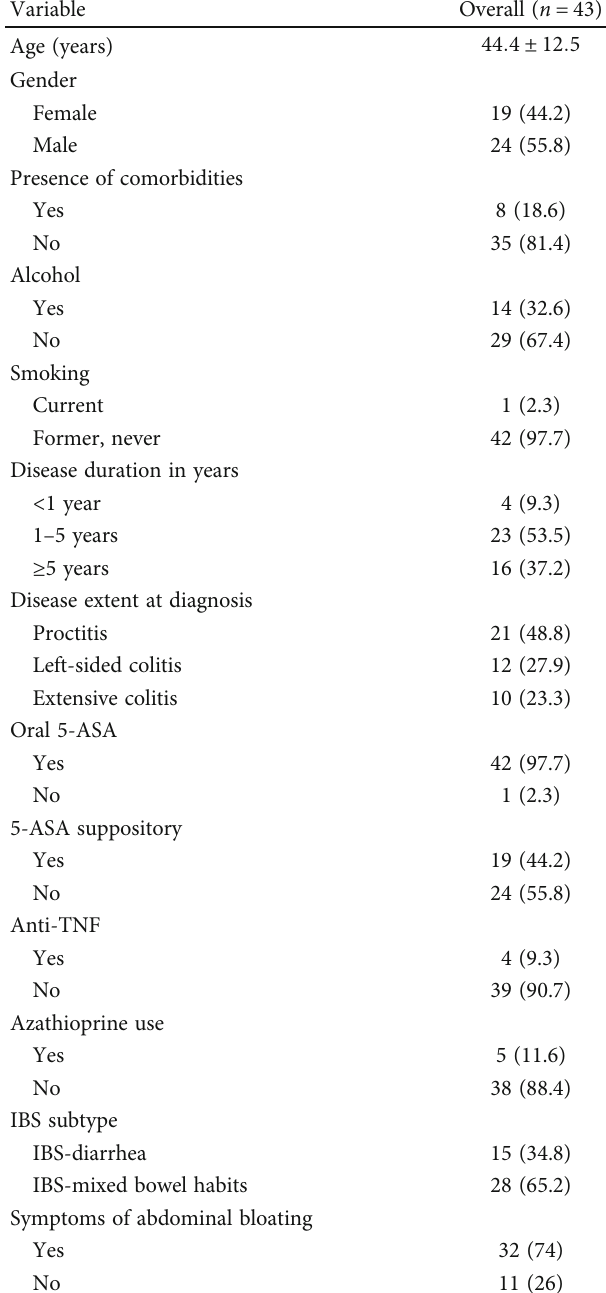
Table 1: Baseline patient